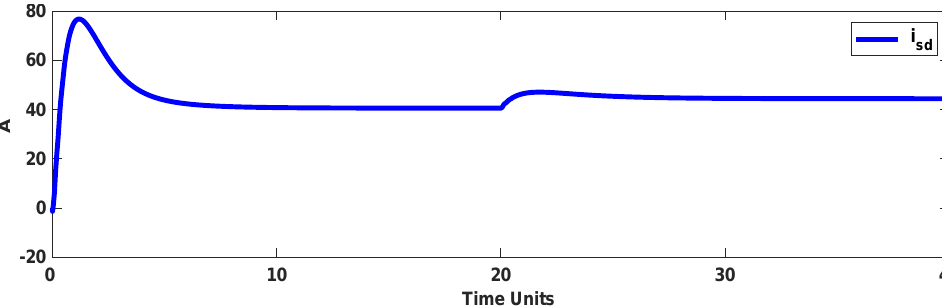
Figure 11. Stator current in the faulty condition (d-component).